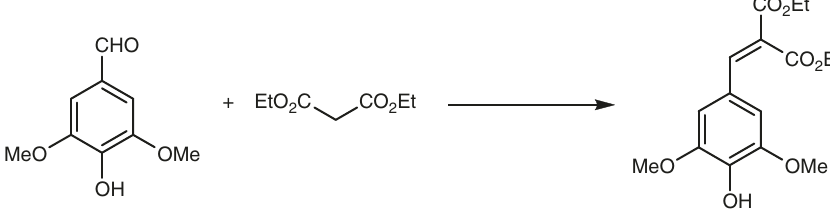
Fig. 6 Preparation of DES. DES synthesized through Knoevenagel condensation of syringaldehyde and